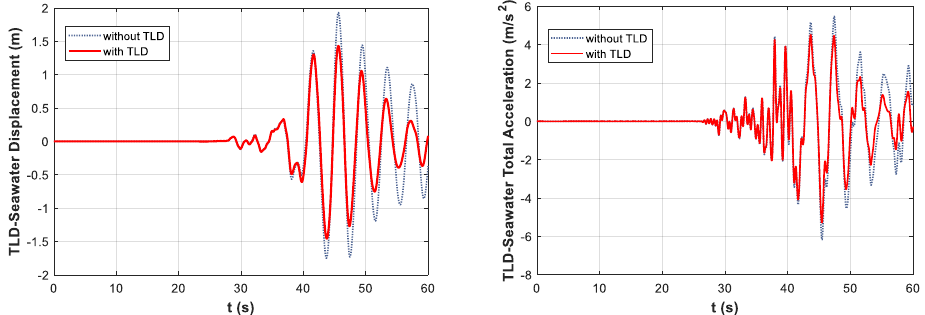
Figure 17. AHS optimization of the 40-story structure displacement – time and total acceleration – time graphs in the CHICHI/CHY101-N earthquake record for TLD – chloroform.